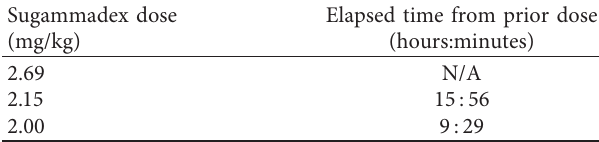
Table 2: Sugammadex dosing. Sugammadex dose